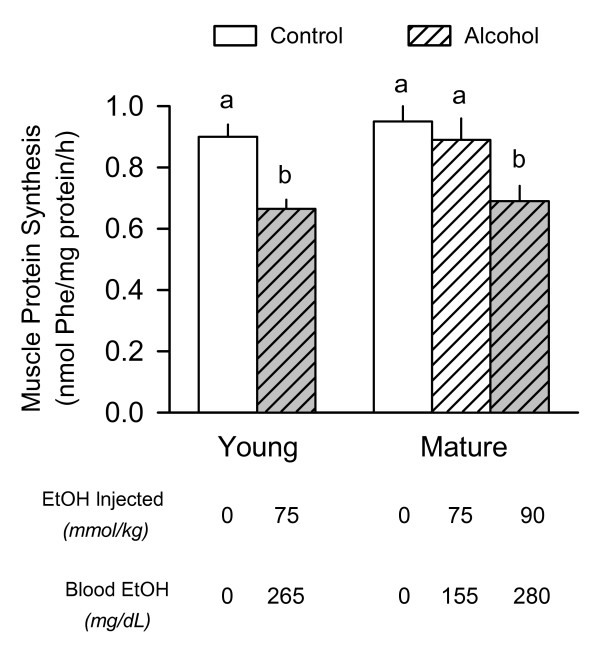
Effect of acute alcohol intoxication on the in vivo rate of protein synthesis in skeletal muscle from young and mature rats. Rats were injected intraperitoneally with either ethanol or saline (control) and protein synthesis in the fast-twitch gastrocnemius muscle was determined 2.5 h thereafter by incorporation of [3H]-phenylalanine (Phe) into protein. Two groups of mature rats were used in this study; rats in group 1 received the same amount of alcohol normalized to body weight as young rats (i.e., 75 mmol/kg), while rats in group 2 were injected with alcohol at a dose of 90 mmol/kg. The approximate blood alcohol concentration achieved in each of the three groups is presented at the bottom of the graph and the absolute values (means ± SEM) are presented in the text. Values for protein synthesis are means ± SEM where the sample size was 10, 10, 6, 7, 9, and 9 for the six groups, respectively. Values with different letters are significantly different from each other, P < 0.05. Values which share a common letter are not statistically different.